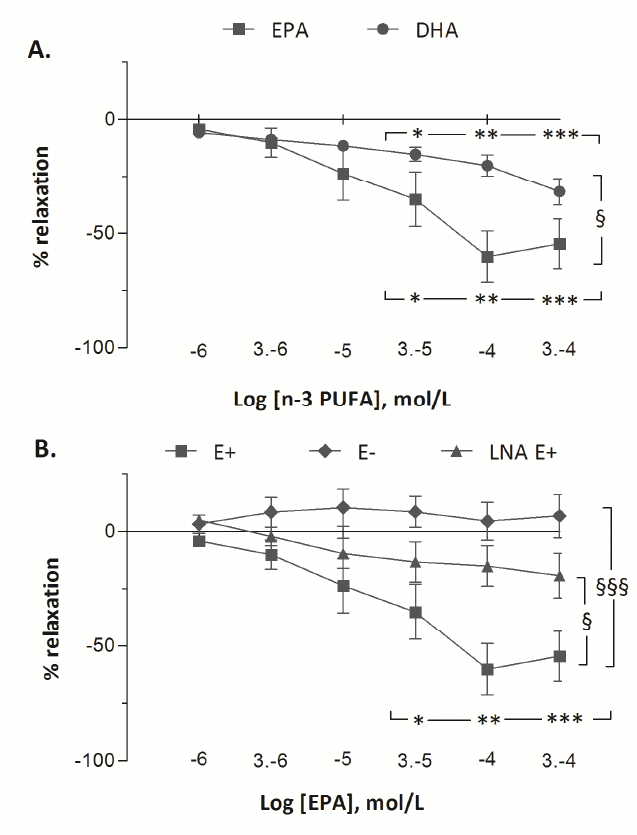
Figure 3. ( A ). Vascular response to incremental increase in EPA and DHA in fetal pulmonary artery rings with intact endothelium (E+ rings). After pre ‐ contraction with 5 ‐ HT ( 100 μ M) , EPA causes